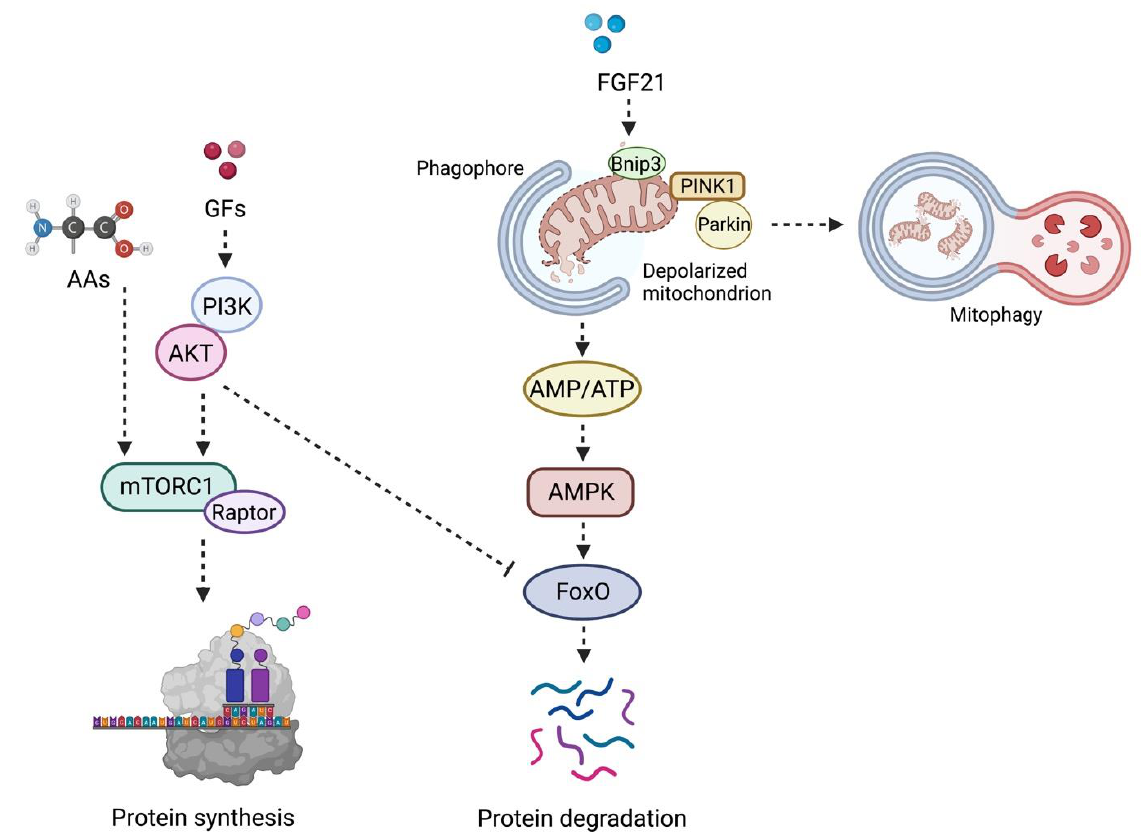
Figure 1. Schematic Representation of the Coordinated Regulation of the Mammalian Target of Rapamycin and Mitophagy in Muscle Protein Synthesis and Degradation. In the presence of growth factors (e.g., insulin, insulin-like growth factor 1, growth hormone), the phosphoinositide 3-kinases-protein kinase B (PI3K) is activated and triggers muscle protein synthesis via the mammalian target of rapamycin complex 1 (mTORC1). The latter complex is also positively modulated by amino acid availability. Conversely, downregulation of PI3K signaling induces translocation of Forkhead box O (FoxO) into the nucleus, where it regulates the transcription of the ubiquitin-ligases muscle ring finger 1 (MuRF1) and muscle atrophy F-box (MAFbx) genes. The activation of this signaling pathway induces degradation of sarcomere components and ignites a muscle pro-atrophy response. The same degradative molecular program is also triggered by fibroblast growth factor 21 (FGF21) in the setting of mitochondrial dysfunction and oxidative stress. In this case, the release of FGF21 stimulates the expression of the mitophagy-related protein B-cell lym- phoma 2 interacting protein 3, paralleled by recruitment of the phosphatase and tensin homo- log-induced kinase 1 (PINK1) through the translocases of the inner and the outer membranes and its activation at the site of depolarized mitochondria. This event promotes the sequestration of the E3 ubiquitin ligase Parkin at the outer mitochondrial membrane and guides the clearance of dys- functional organelles. Finally, depolarized mitochondria are coated and prepared for disposal by the ubiquitin-binding adaptor protein p62/sequestosome-1 and the recruitment of the microtu- bule-associated proteins 1A/1B light chain 3B (LC3). This enables the transfer of mitochondria to lysosomes. FoxO-dependent atrophy is also pursued when severely damaged and bioenergetically incompetent mitochondria are not efficiently removed and, thus, the AMP/ATP ratio increases, which engages 5′ AMP -activated protein kinase (AMPK). Abbreviations: AA, amino acid; AMP, adenosine monophosphate; ATP, adenosine triphosphate; GF, growth factor; TIM23, translocase of the inner membrane 23; TOM, translocase of the outer membrane. Created with BioRender.com, accessed on 26 August 2022.